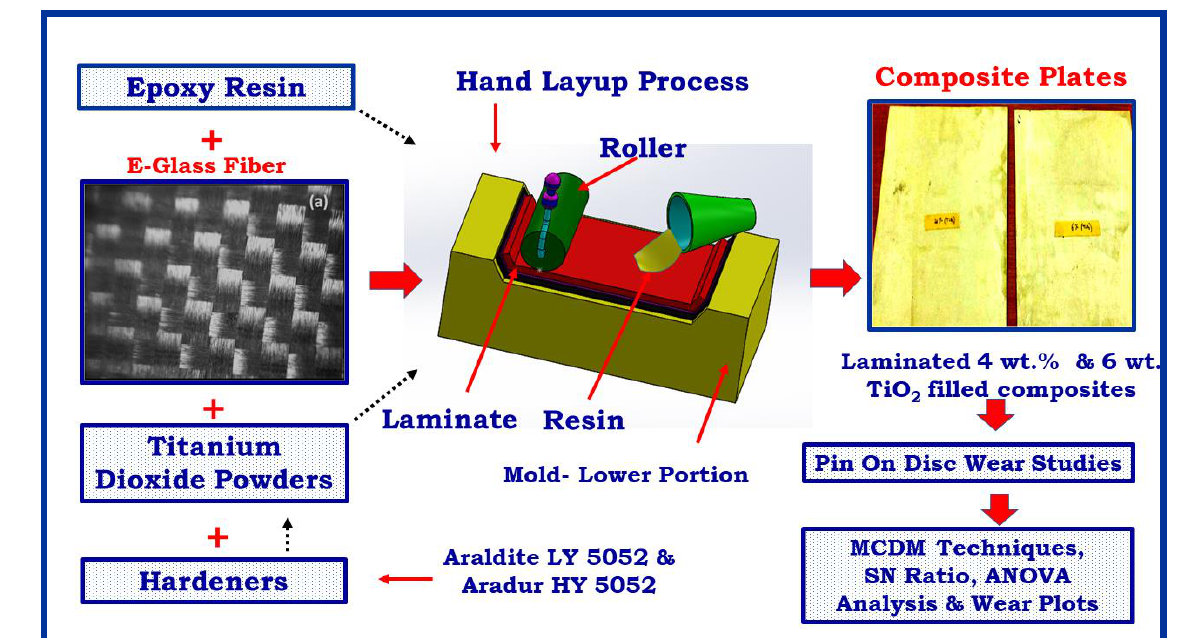
Figure 1. Micro-structural image for E-glass fiber, photographic image of laminated 4 wt% and 6 wt. TiO 2 filled composites and process flow of present work.